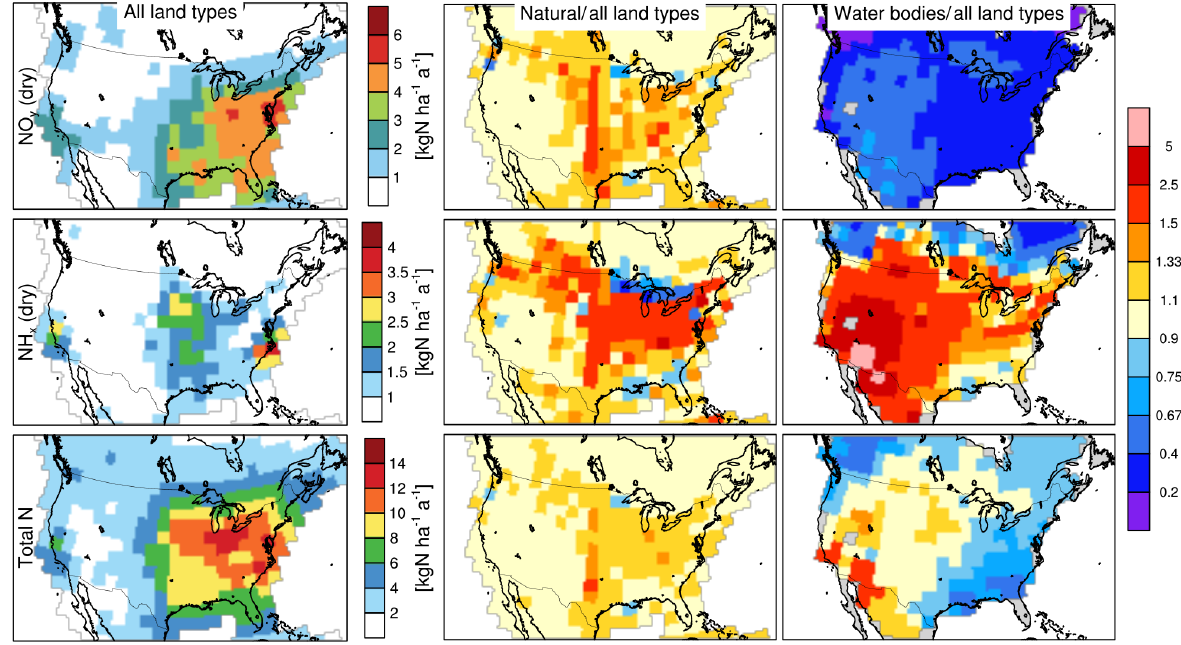
Figure 5. Simulated reactive nitrogen deposition (left column) from dry oxidized nitrogen deposition (top row), dry reduced nitrogen de- position (middle row), and total nitrogen deposition (bottom row) over the 2008–2010 period. The ratio between the deposition on selected land types and the grid cell average deposition is shown in the middle (for natural vegetation) and right columns (water bodies).